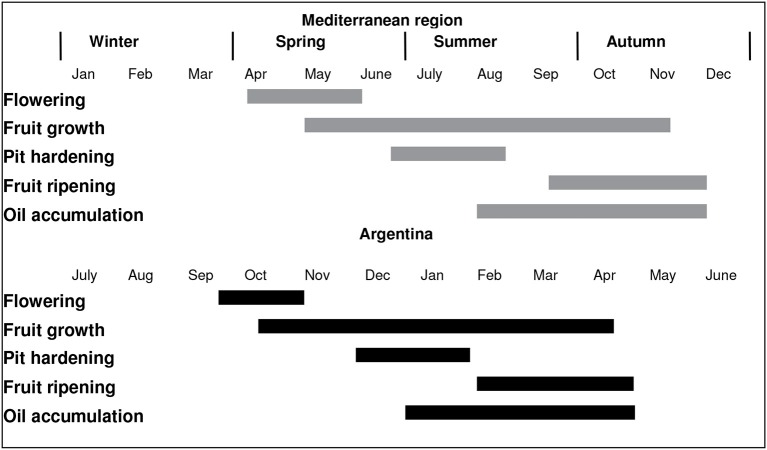
The chronological sequence of the main phenological stages of olive cultivation in the Mediterranean Basin compared with the main olive growing regions in Argentina. The Mediterranean and Argentine sequences are adapted from Sanz-Cortés et al. (2002) and Gómez del Campo et al. (2010), respectively.